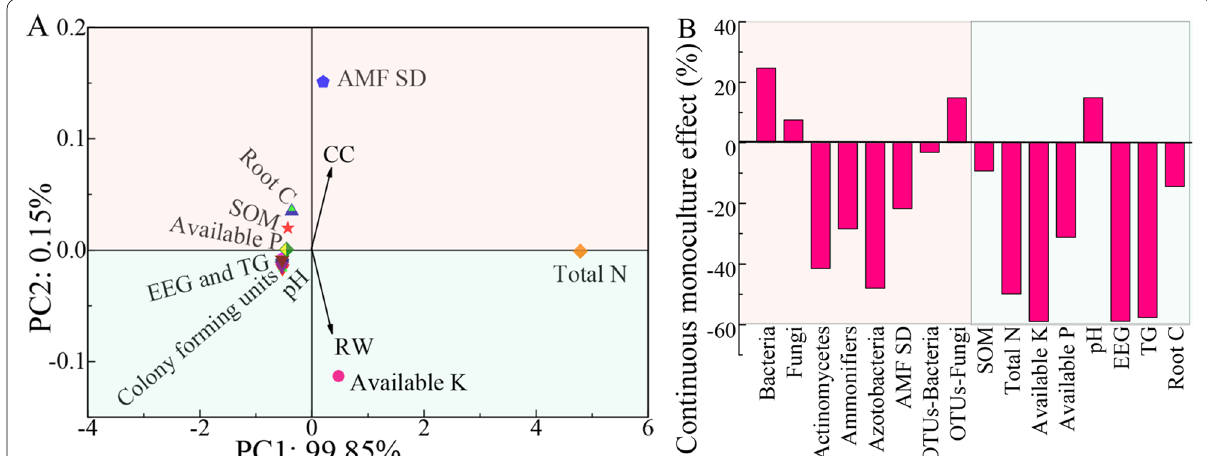
Fig. 5 Principal component analysis (PCA) of rhizosphere parameters and continuous monoculture effect in A. sinensis seedlings between RW and CC, n 3. SOM, soil organic matter; total N, total nitrogen; available P, available phosphorus; available K, available potassium; EEG, easily extractable = glomalin; TG, total extractable glomalin; root C, root colonization rate; AMF SD, AMF spore densities. A principal component analysis (PCA) of rhizosphere parameters in A. sinensis seedlings between RW and CC. B Continuous monoculture effect (CME) of rhizosphere parameters in A. sinensis seedlings between RW and